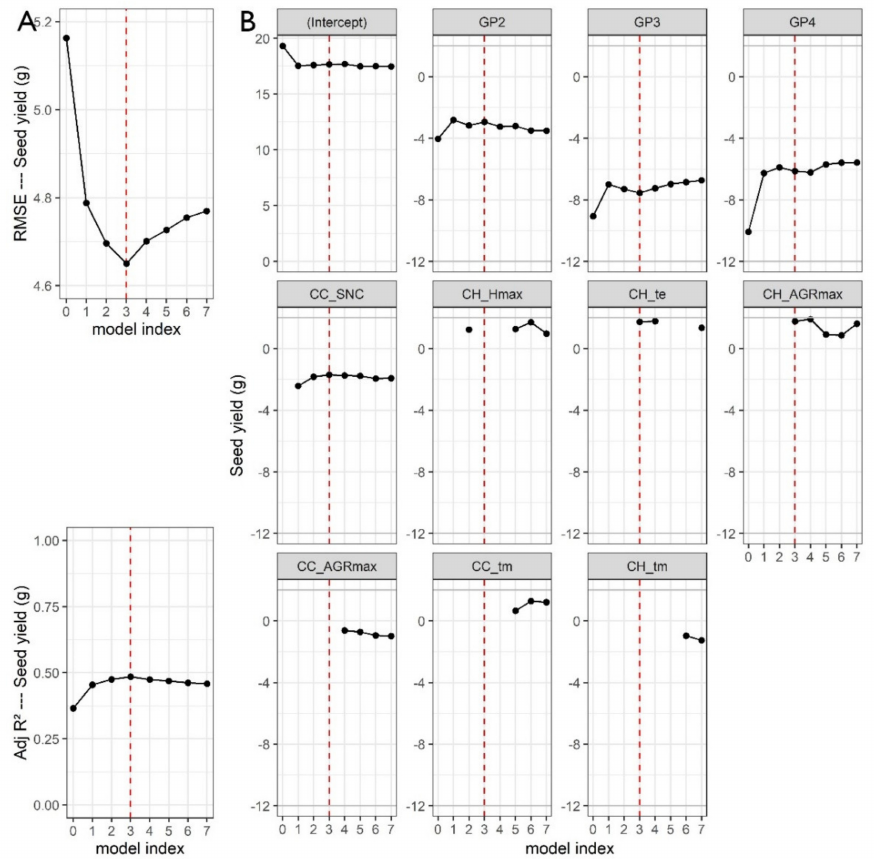
Figure 8. MLR model building overview for SY with RMSE and Adj. R 2 evolution ( a ). The red dashed line indicates the selected (best) model with the lowest RMSE. The subset selection regression with normalized UAV phenotypic variables included a 10 k-fold cross validation. In each subsequent step one variable was added, and all possible combinations were evaluated. The model index = 0 included only the groups (GP1-4, GP1 is the reference group) as dummy variables. For the abbreviations, see Table 1. Graphs are provided per variable with the value of their respective coe ffi cients ( b ).